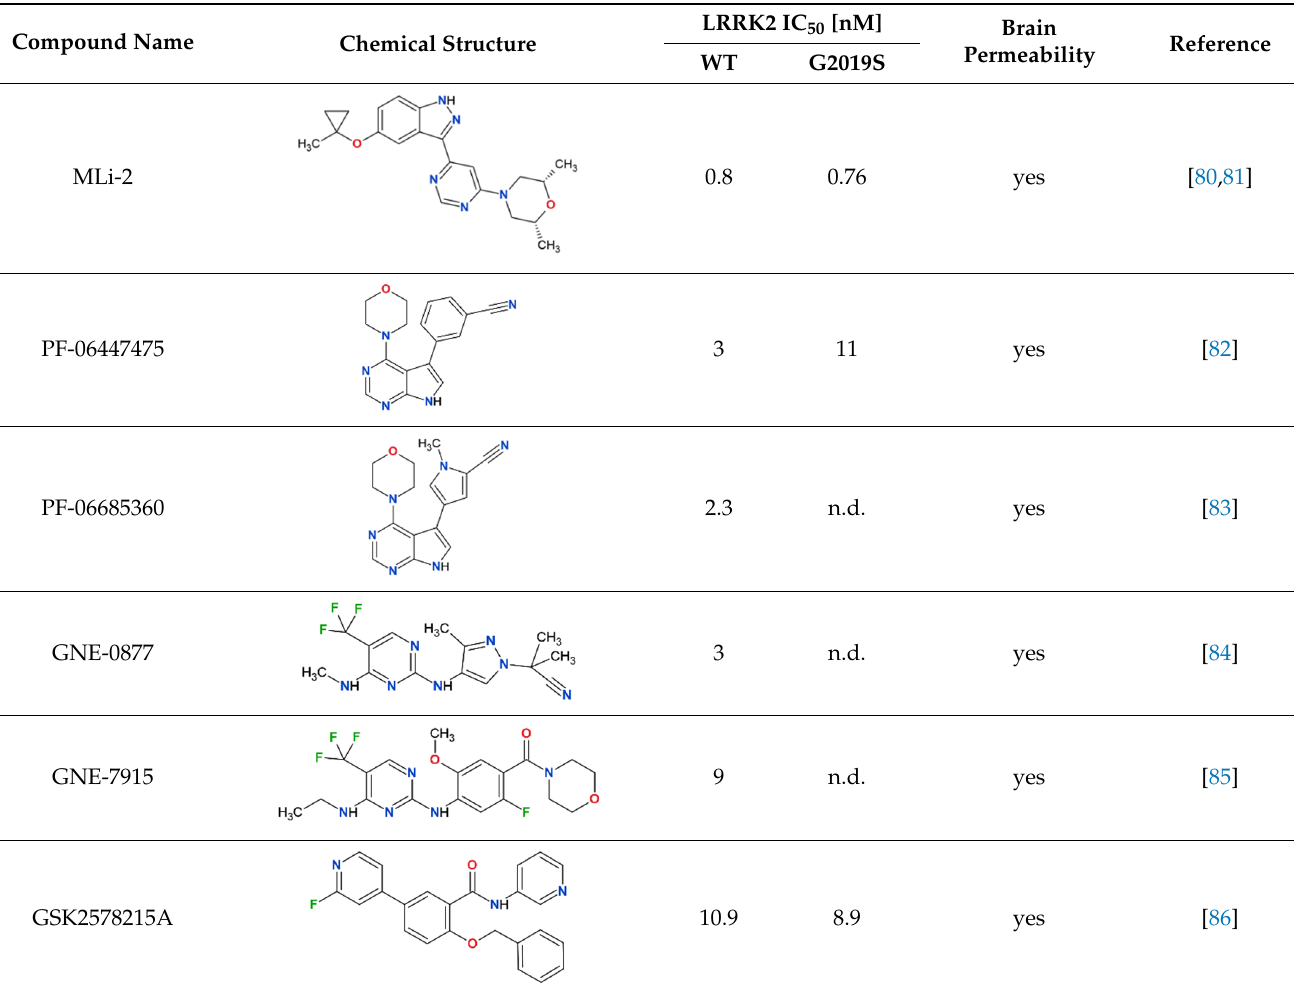
Table 2. Most used, orthosteric LRRK2 kinase inhibitors and their selected properties.